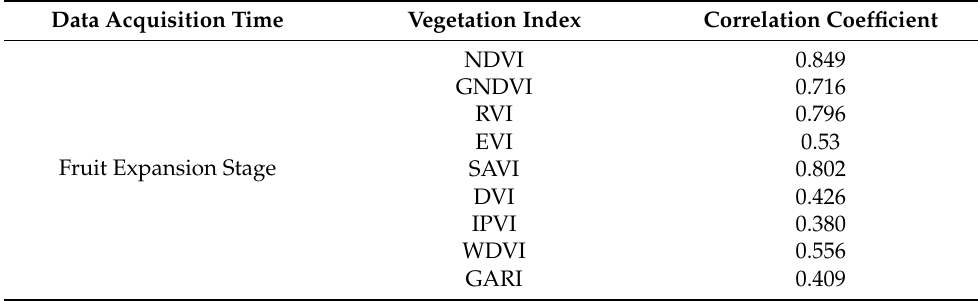
Table 7. Results of the correlation analysis between the LAI measurements and the top five vegetation